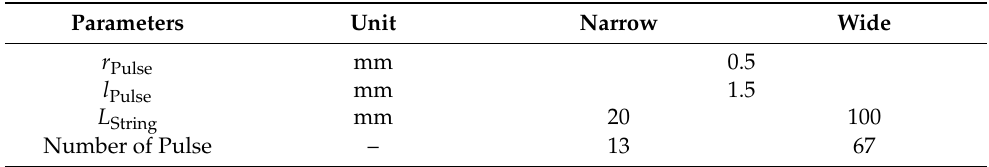
Table 1. The condition of energy